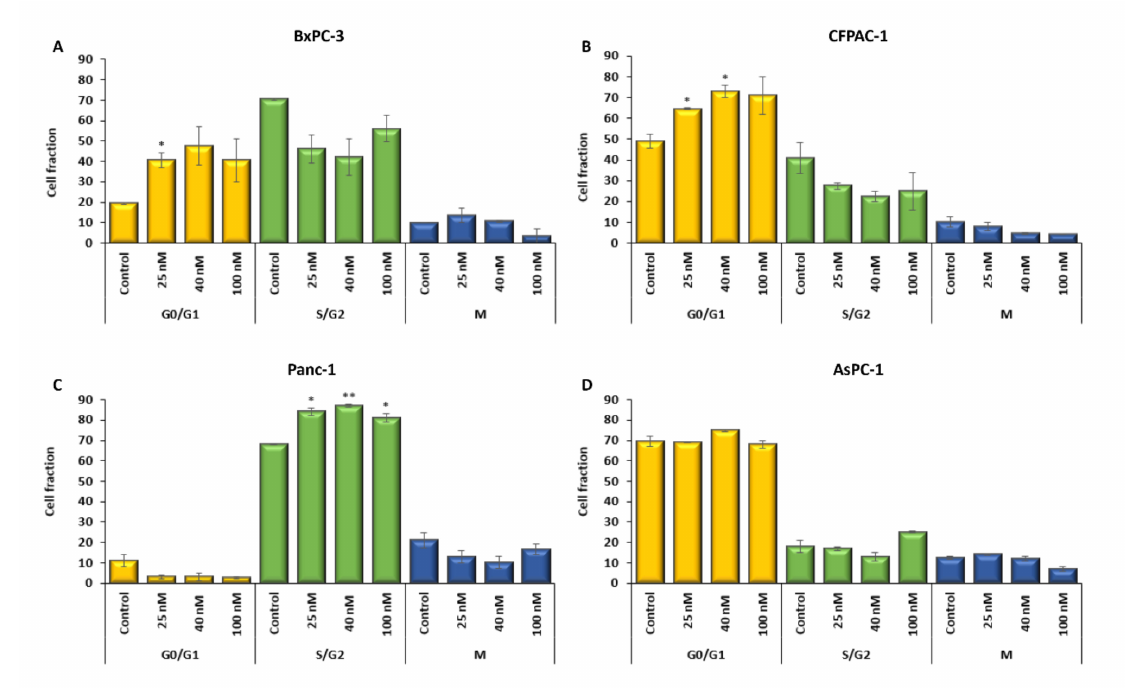
Figure 4. Cell proliferation in PDAC cells in vitro assessed with the Cell-Clock assay (Bio-Color, UK). ( A ) BxPC-3, ( B ) CFPAC-1, ( C ) PAnc-1, and ( D ) AspC-1. Proportions of cells in different phases—for the control and with digitoxin treatment (25 nM, 40 nM, and 100 nM) for 48 h. G0/G1 (yellow), S/G2 (green), and M (blue). Error bars = SEM, Student’s t -test * p ≤ 0.05; and ** p ≤